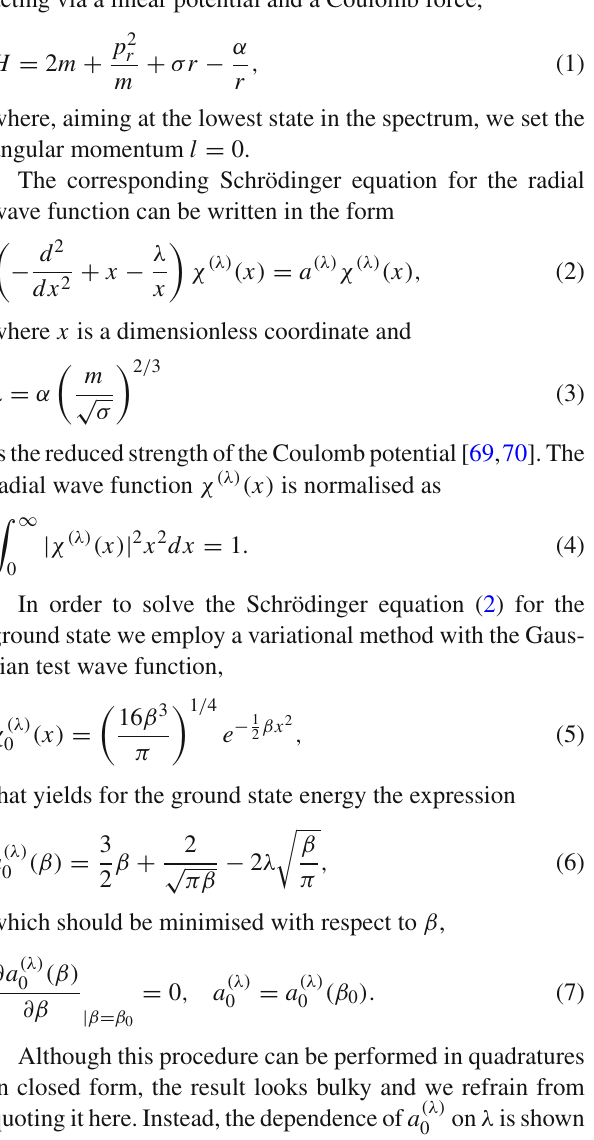
Fig. 1 Dependence of the ground state eigenvalue a (λ) Coulomb potential strength